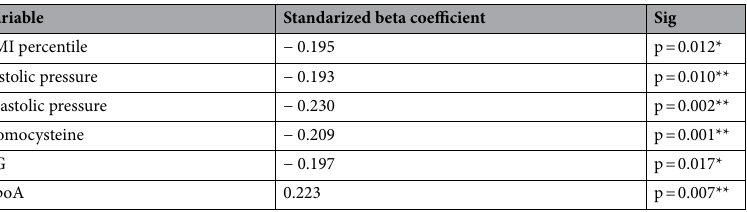
Table 5. Model of multivariate analysis of variables which proved significant in univariate analysis. Vitamin D was used as the dependant variable. BMI percentile body mass index percentile, TG triglycerides, ApoA apolipoprotein A1. *p < 0.05, **p < 0.01.